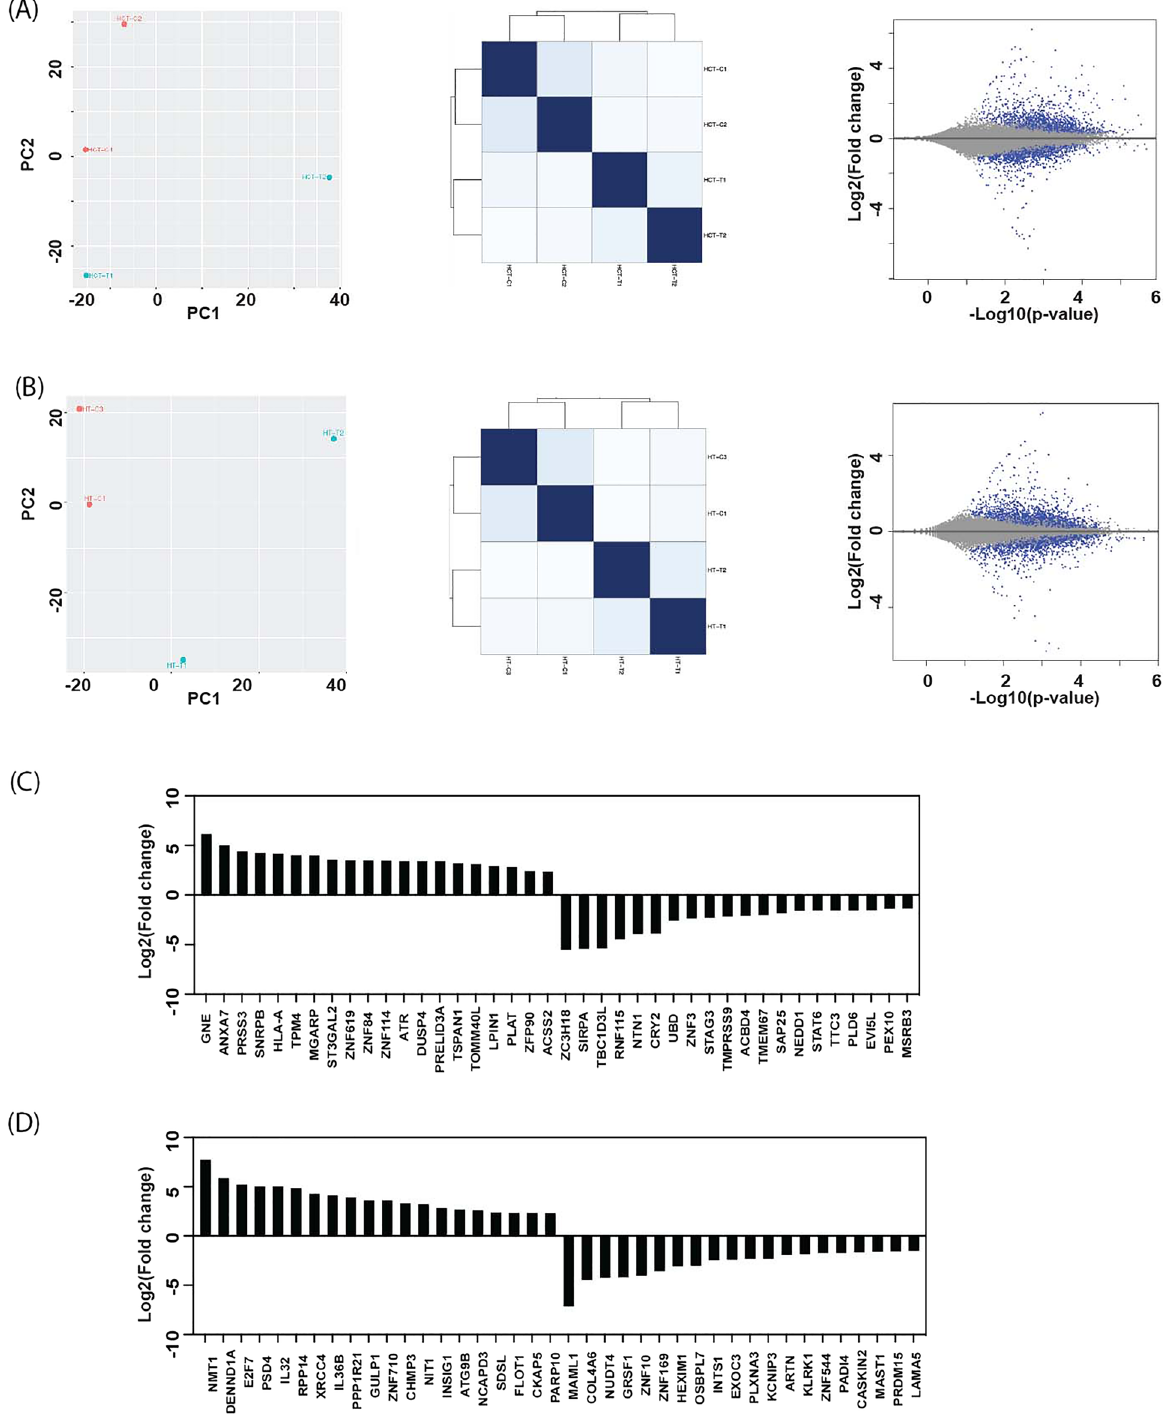
Figure 8. Comprehensive transcriptome dynamics by the MG7 treatment in HCT-116 and HT-29 cells. Principal-component analysis (PCA) of directional RNA-seq data (left panel), heat map and hierarchical clustering of transcriptional pattern analysis (middle panel), and volcano plot indicating differentially expressed transcripts (right panel) after MG7 treatment by HCT-116 cells ( A ) and HT-29 cells ( B ). Heatmap describing fold changes for top 20 up-regulated and down-regulated transcripts indicating statistically significant differences between the MG7-treated group and the control group in HCT-116 ( C ) and HT-29 cells ( D